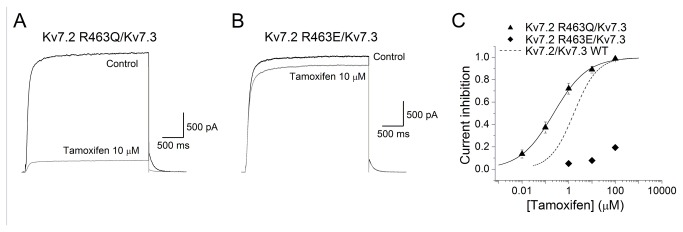
The affinity of the heteromeric mutant channels Kv7.2 R463Q/Kv7.3 and Kv7.2 R463E/Kv7.3 for PIP2 correlates with the degree of current inhibition by tamoxifen.A and B, Superimposed representative Kv7.2 R463Q/Kv7.3 and Kv7.2 R463E/Kv7.3 current traces recorded in control (black) and in presence of 10 µM tamoxifen (gray). Currents were evoked depolarizing the membrane to +40 mV for 3 s and then repolarizing to -60 mV. C, Concentration–effect relationship for the inhibitory effect of tamoxifen on Kv7.2/Kv7.3 WT channels (dashed line) and the mutants Kv7.2 R463Q/Kv7.3 and Kv7.2 R463E/Kv7.3 (triangles and diamonds respectively). The line represents the fit of the experimental data by a Hill equation with the values given in the text. Each point represents the mean ± SEM from n = 5 to 6 experiments.